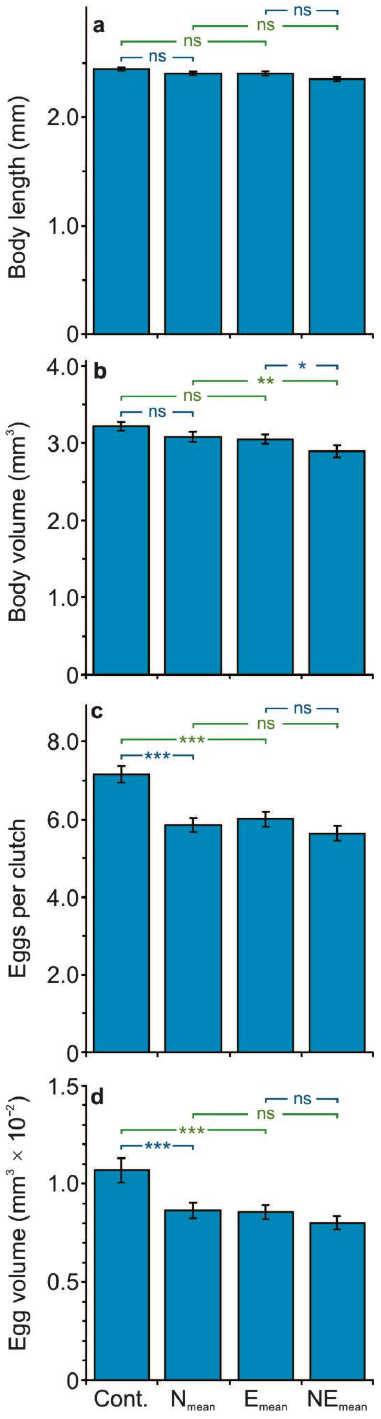
Figure 2. Mean values (± 1 SE) of: ( a ) body length, ( b ) body volume, ( c ) clutch size (the number of eggs per ovigerous female), and ( d ) egg volume of 5-day-old D. magna from the control variant (Cont.) and from variants of a single or combined mean density of polystyrene NPs (N mean for the combined data from N l = 10 3 , Nm = 10 6 , and N h = 10 9 particles L − 1 ) and the mean concentration of enrofloxacin (E mean for the combined data from E l = 10 and E h = 100 ng L − 1 ). Statistical significance is accepted at * p < 0.05, ** p < 0.005, or *** p < 0.0005, ns stands for non-significant. The NPs effect is marked on blue, and the enrofloxacin effect on green.